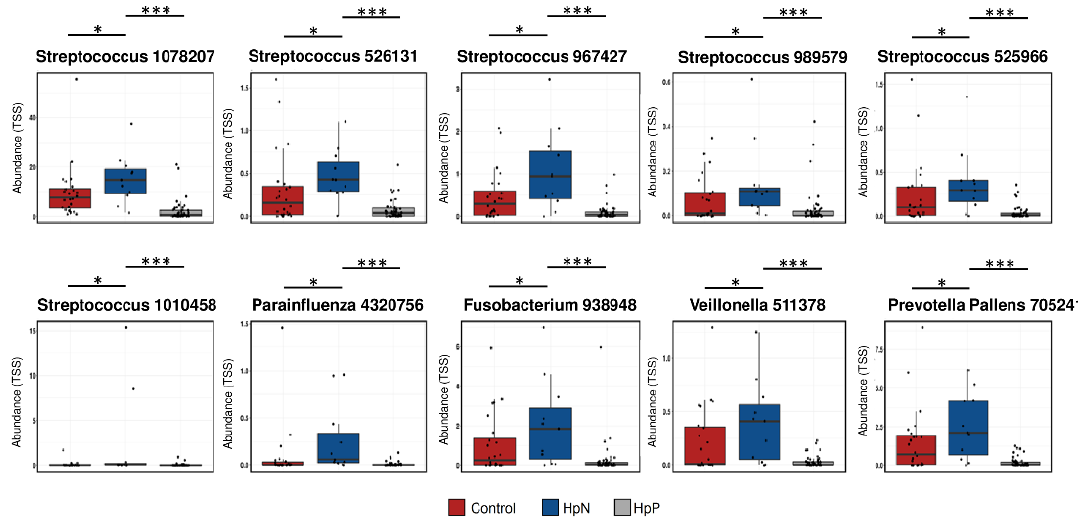
Figure 3. Univariate analysis for selected species according to comparison groups. Each selected species of abundance was shown by the HpN, HpP and control groups. * p < 0.05, *** p < 0.001.